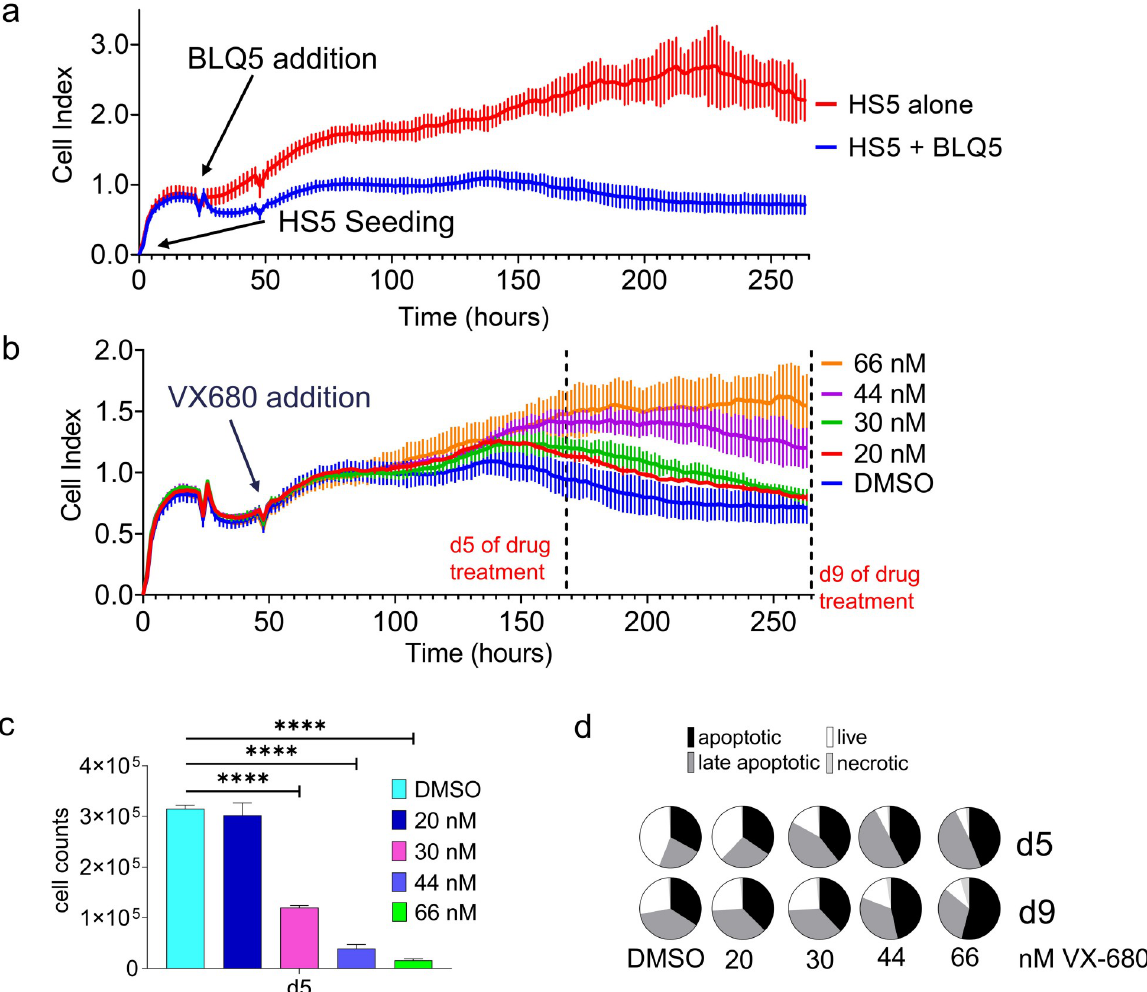
Fig 7. Treatment of BLQ5 co-cultured on human MSC with VX-680. (A) BLQ5 cells were plated on HS5 stromal cells, resulting in a reduction of impedance (n = 3). (B) Treatment of BLQ5 cells with different concentrations of VX-680 as indicated (n = 3). Dotted lines show the d5 and d9 time points at which cells were harvested for (C) live cell numbers determined by Trypan blue exclusion. Statistical significance was determined using one-way ANOVA, followed by followed by Dunnett’s multiple comparison test. Error bars represent standard deviation. p values relative to DMSO control: ���� < 0.0001. or (D) Percentage apoptotic cells characterized by FACS using 7-AAD and Annexin V.